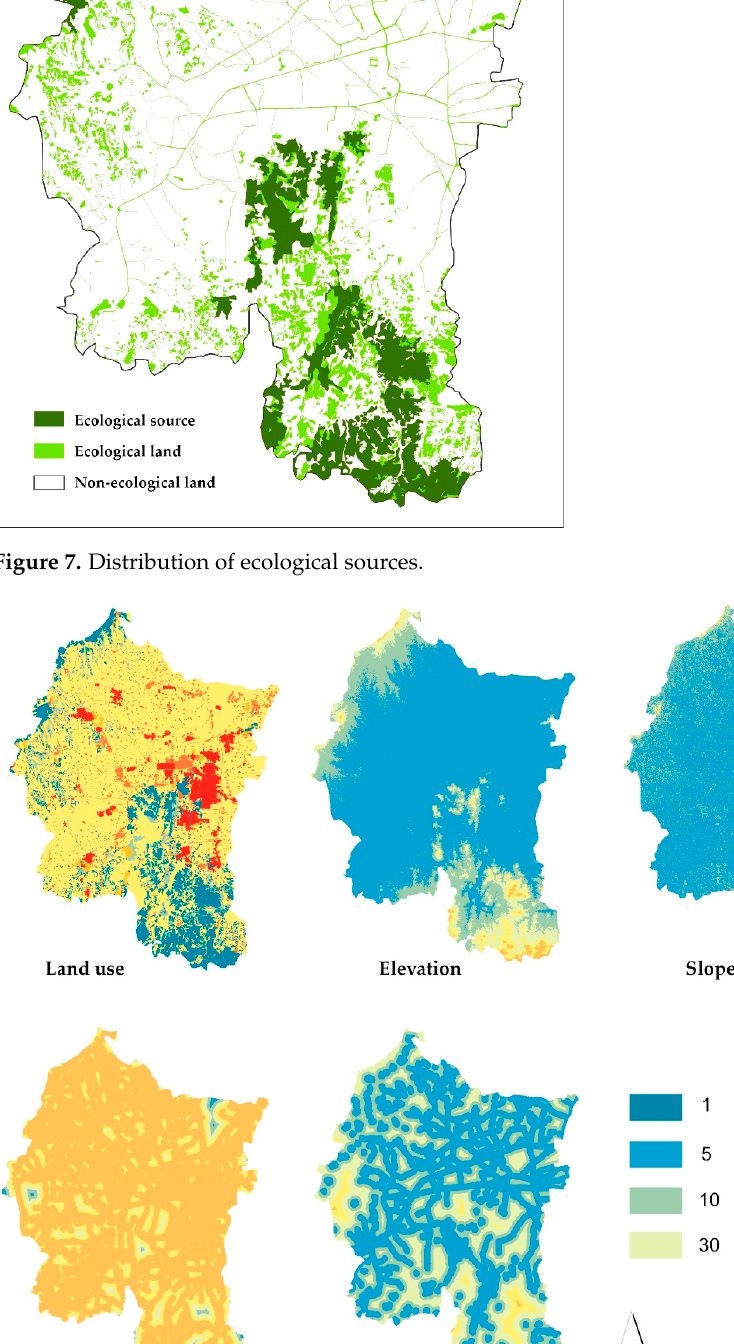
Figure 9. Comprehensive-resistance surface.